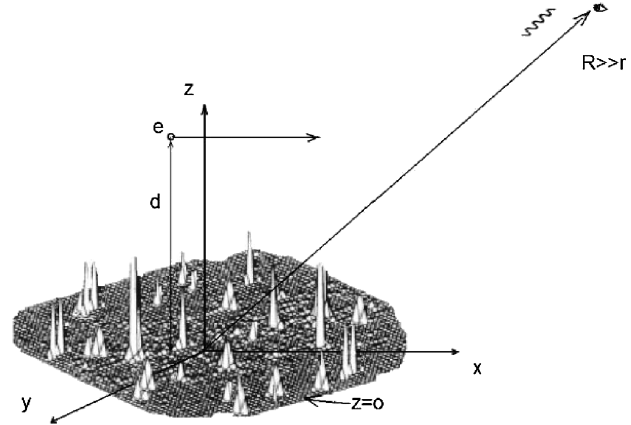
FIG. 1. Geometry of the problem. A charged particle moves parallel to the 0 x axis. The observation point is far away from